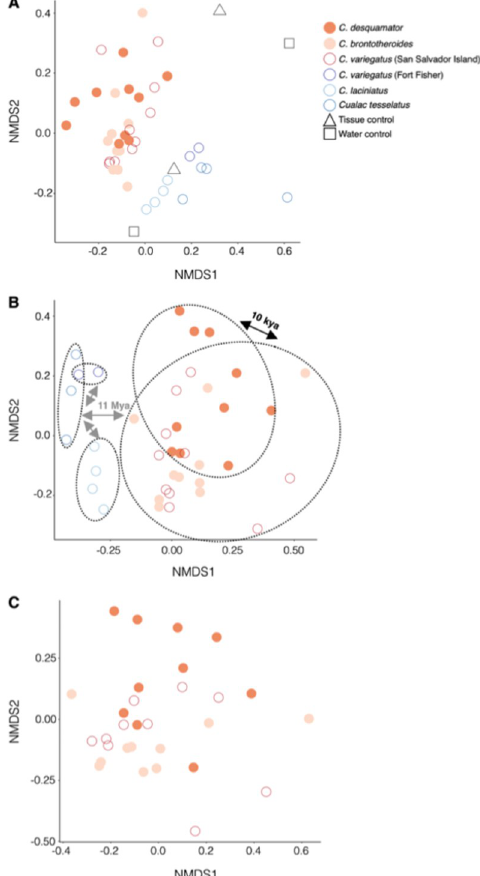
Fig 2. Non-metric multidimensional scaling (NMDS) plots of Cyprinodon pupfish gut microbiomes. A) NMDS plot based on all Cyprinodon pupfish gut samples labeled according to species and diet including controls (n = 44). Closed circles represent the two specialists (scale-eater and molluscivore) and open circles represent generalists. Open squares and triangles represent controls used in this study. B) Shows a NMDS plot of the three Cyprinodon pupfish species (F2 generation) from San Salvador Island and outgroup members gut microbiomes (n = 39). According to Echelle et al. [33], there is ~11.2 Mya phylogenetic divergence of Cualac tessellatus and Cyprinodon pupfish species, which you can see in the gray arrows and text. The black arrow indicates the 10 kya phylogenetic divergence of C . desquamator and the other Cyprinodon pupfish species from San Salvador Island. C) Lastly, a NMDS plot of only the San Salvador Island species gut microbiomes (n =